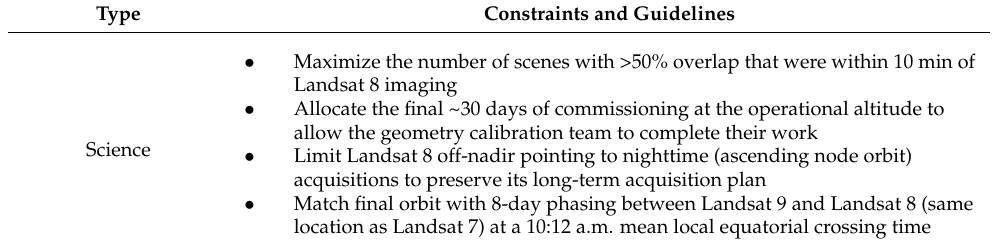
Table 2. Planning